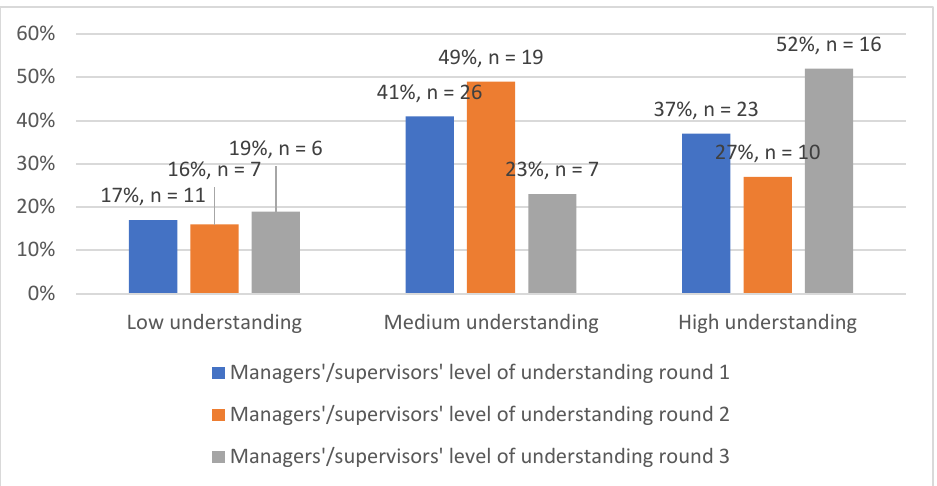
Figure 5. Managers’/supervisors’ level of understanding of the PMDS ( n = 135).